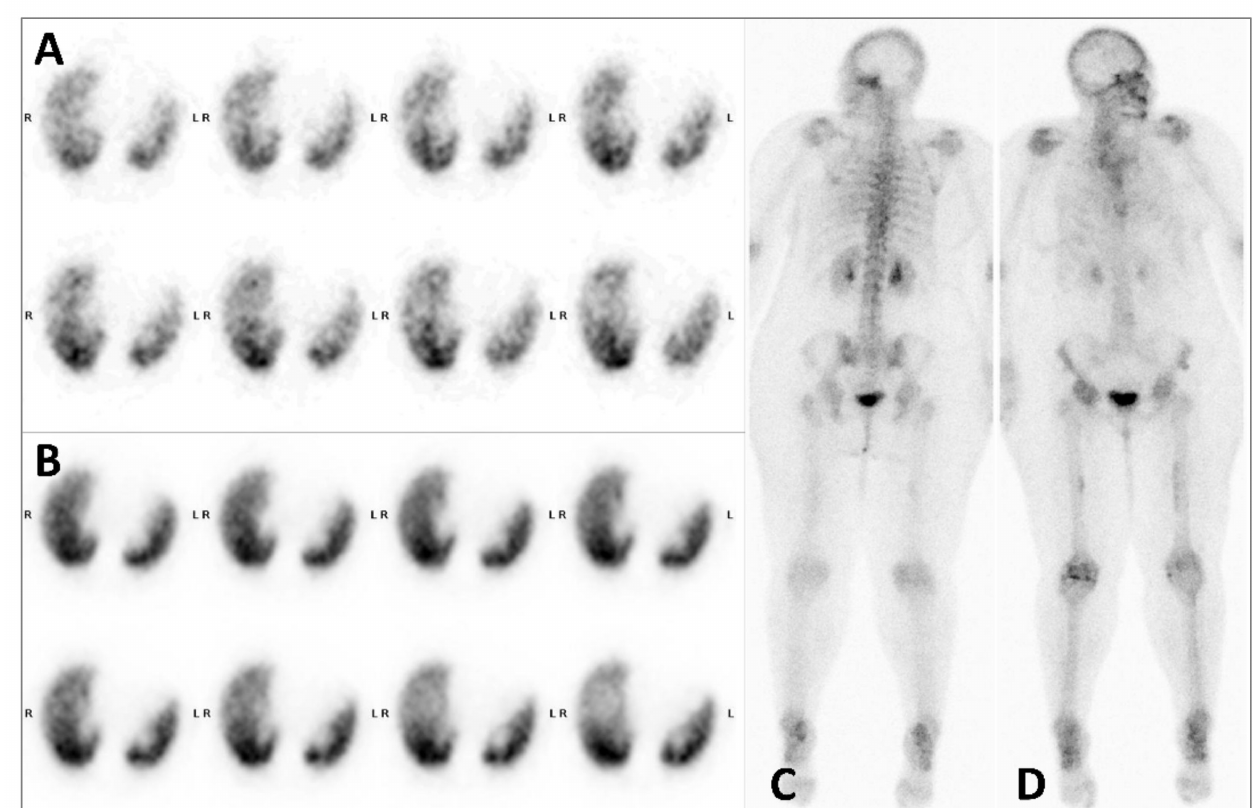
Figure 2. Subsequent scintigraphic investigations with ventilation/perfusion scintigraphy: ven- tilation axial SPECT slices ( A ), perfusion axial SPECT slices ( B ); and follow-up whole body bone scan: posterior view ( C ), anterior view ( D ). Extraosseous uptake on bone scan with 99m Tc-HDP or 99m Tc-methylene diphosphonate ( 99m Tc-MDP) have been well described, with great